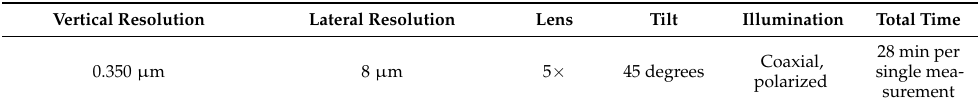
Table 2. Measurements set-up for focus variation microscope.